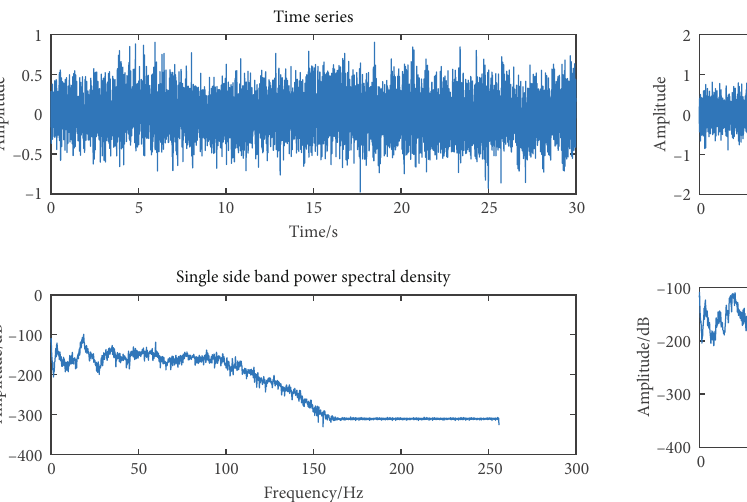
Figure 21: Time series and PSD of the wing in CH3. Figure 22: Time series and PSD of the wing in